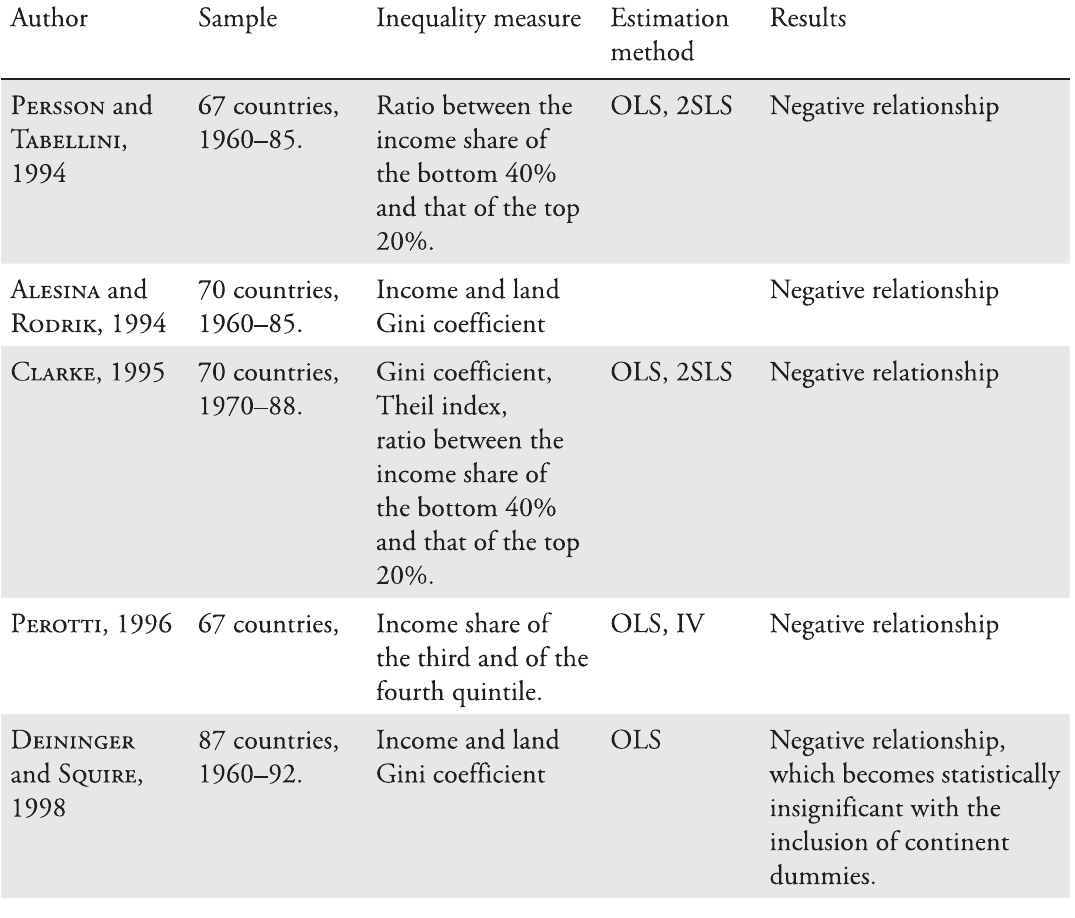
Table 1: An Overview of the Existing Literature on the